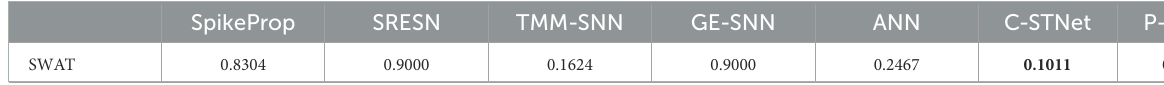
TABLE 5 Nemenyi post hoc test p -values for pairwise comparison between SWAT and other seven approaches.